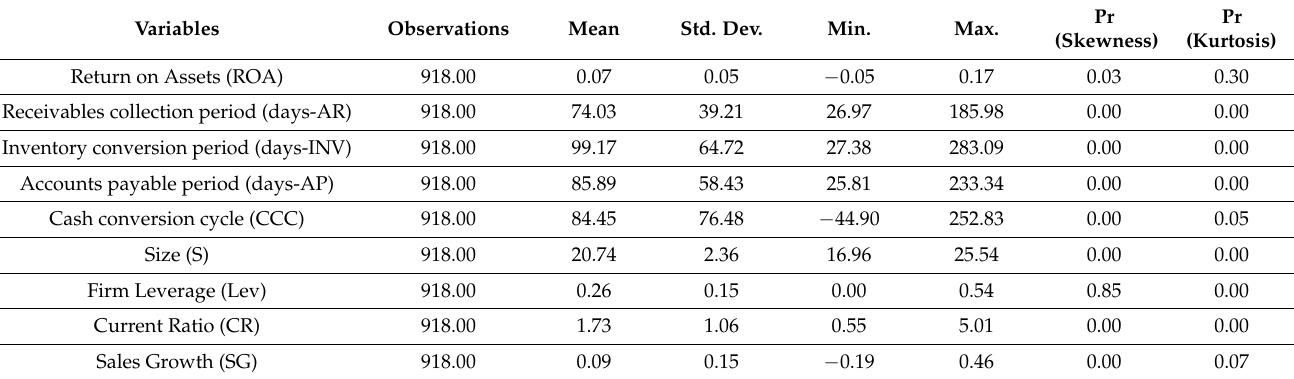
Table 2. Descriptive statistics of the variables (pre-pandemic period, 2010–2019).